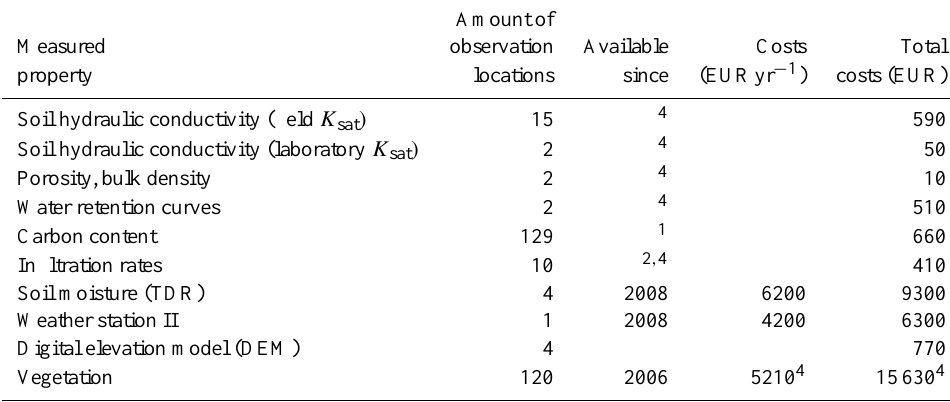
Table 5. Virtual costs of data (in EUR) provided in the third prediction. Amount of Measured observation Available Costs Total property locations since (EURyr − 1 ) costs (EUR) Soil hydraulic conductivity (field K sat ) 15 4 590 Soil hydraulic conductivity (laboratory K sat ) 2 4 50 Porosity, bulk density 2 4 10 Water retention curves 2 4 510 Carbon content 129 1 660 Infiltration rates 10 2 , 4 410 Soil moisture (TDR) 4 2008 6200 9300 Weather station II 1 2008 4200 6300 770